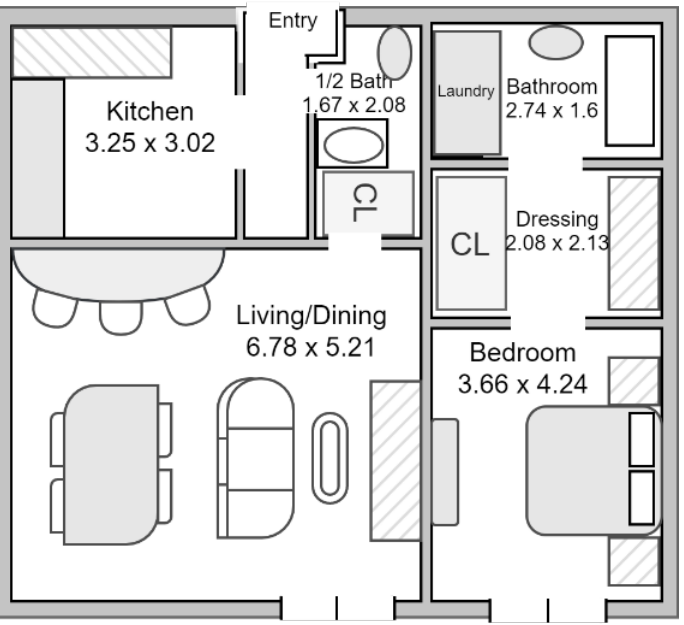
Figure 2. Floorplan of one-bedroom apartment used as acoustic environment for the synthetic database, dimensions in meters [47].